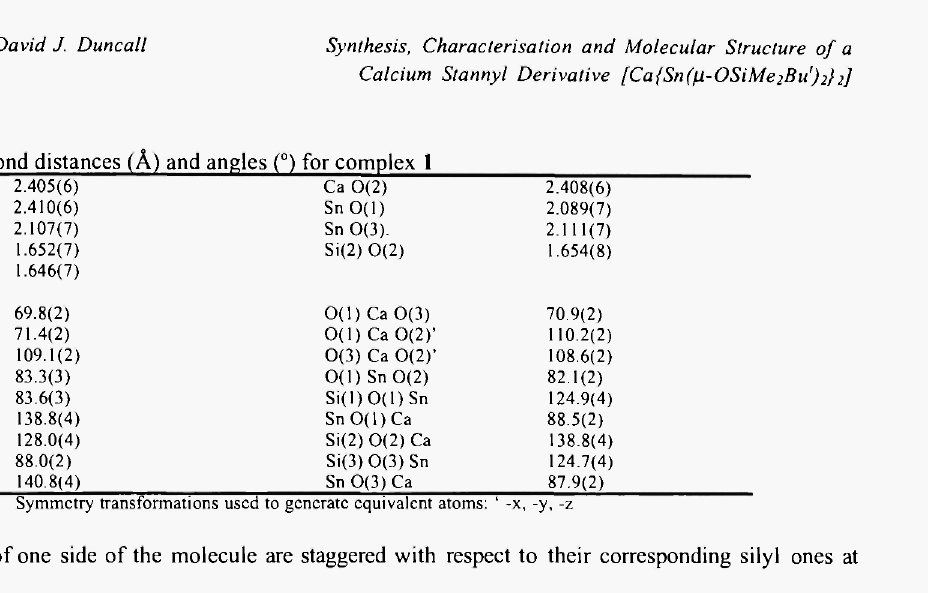
Table 2 Selected Bond distances ( A) and angles (") for complex 1 Ca O(l) Ca 0(3) Sn 0(2)